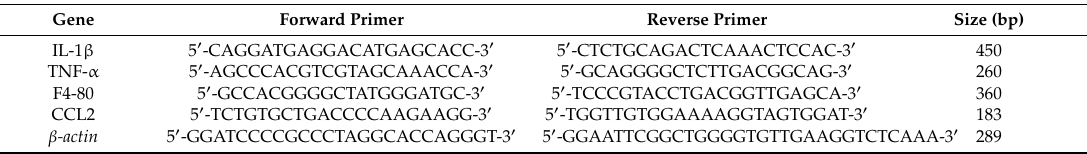
Table 3. Oligonucleotide sequence of primers for